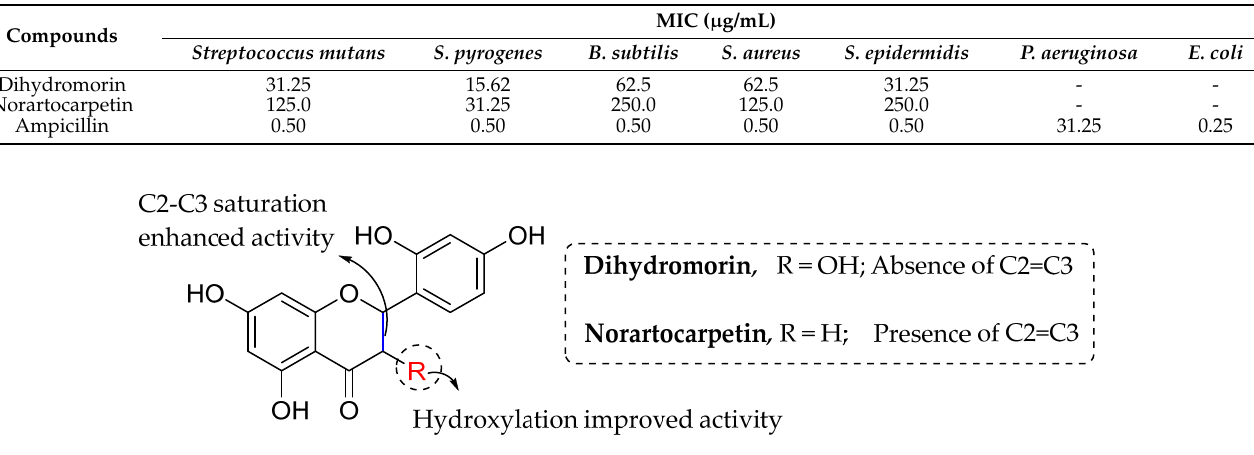
Figure 27. SAR of flavonoids isolated from Artocarpus heterophyllus as antibacterial agents [96]. Nielsen et al. (2004) synthesized a series of carboxylic chalcones and executed an in vitro antibacterial assay against S. aureus . The results of the antibacterial activity can be observed in Table 18. Some important structural features of carboxylic chalcones as antibacterial agents have been discussed. Firstly, substitution in ring B at meta position [4 (cid:48) - Carboxy-3-trifluoromethyl-chalcone ( 10h ), 4 (cid:48) -Carboxy-3-bromo-chalcone ( 10i ), 4 (cid:48) -Carboxy-